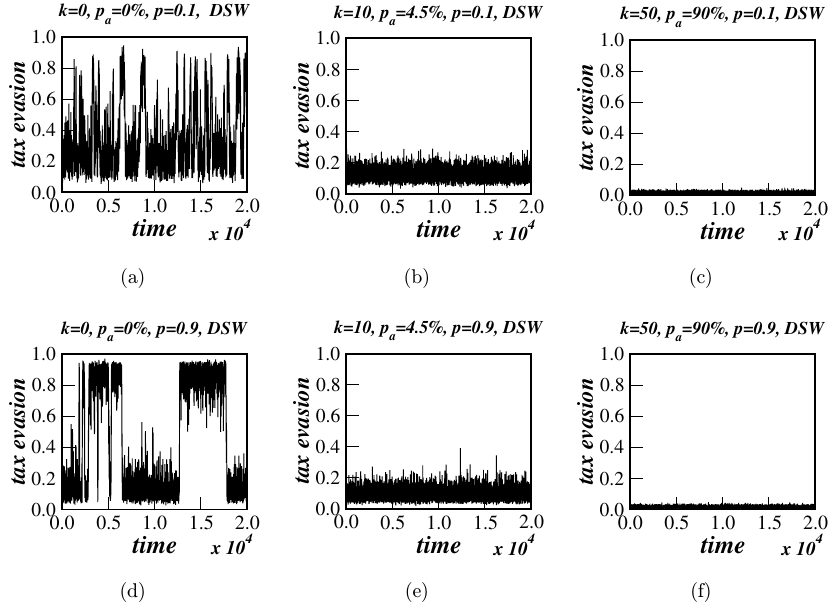
Fig. 5. The same simulation design as in Fig. 2, but now on DSW for p ¼ 0 : 1 and 0 : 9